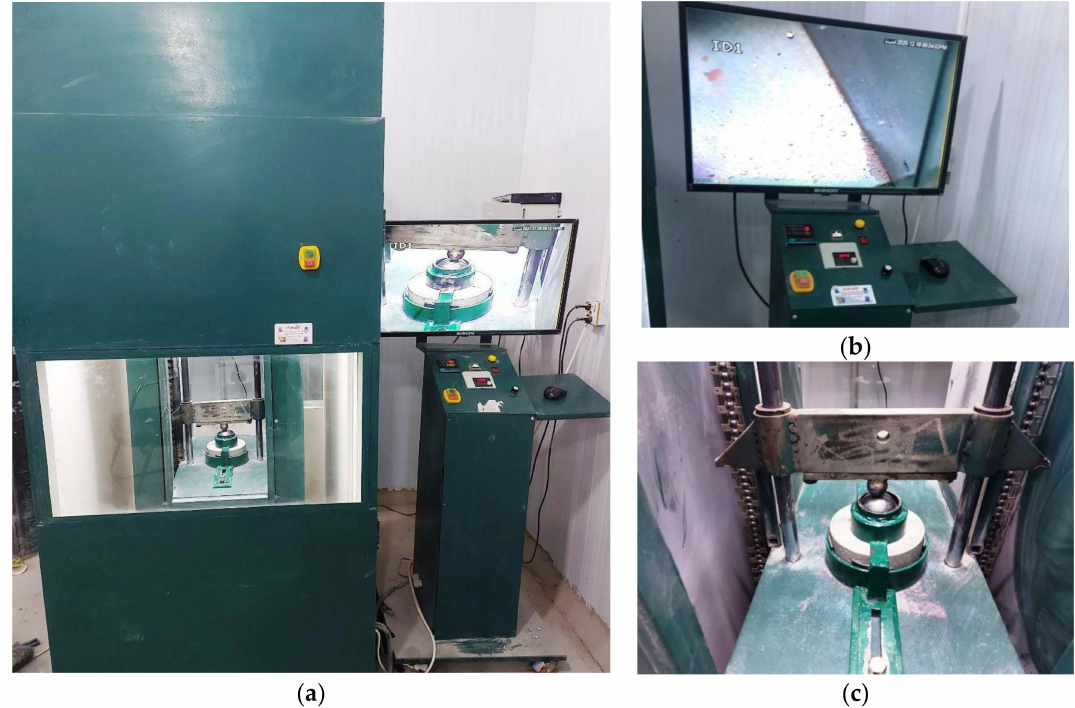
Figure 2. The automatic repeated impact testing machine ( a ) the impact machine; ( b ) crack observation; ( c ) the impact load and holding